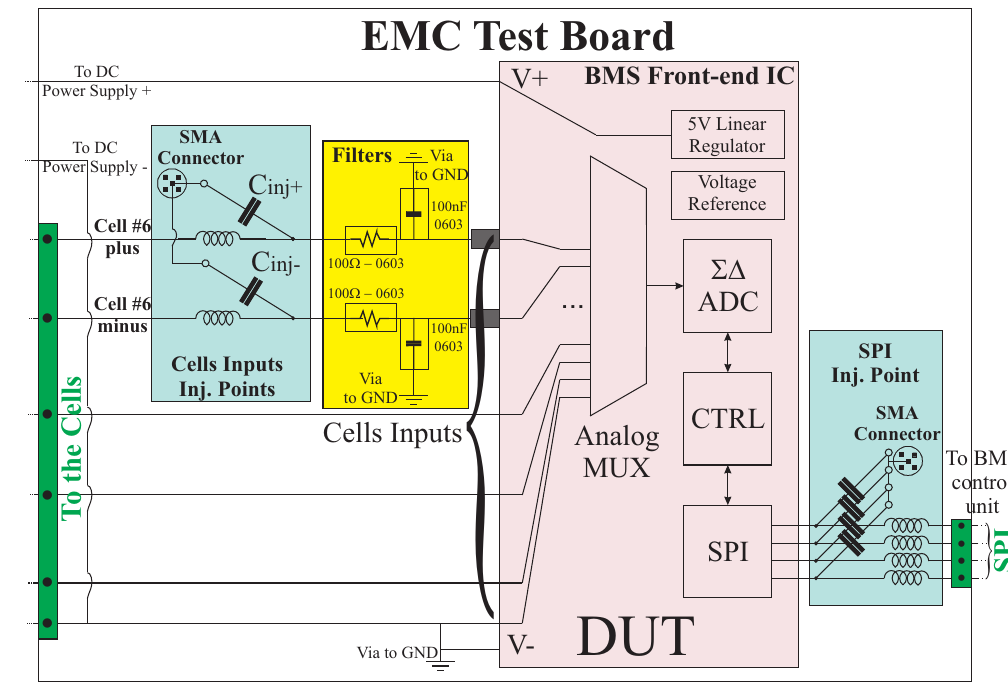
Figure 2. Simplified schematic diagram of the BMS integrated circuit (IC) direct power injection (DPI) test